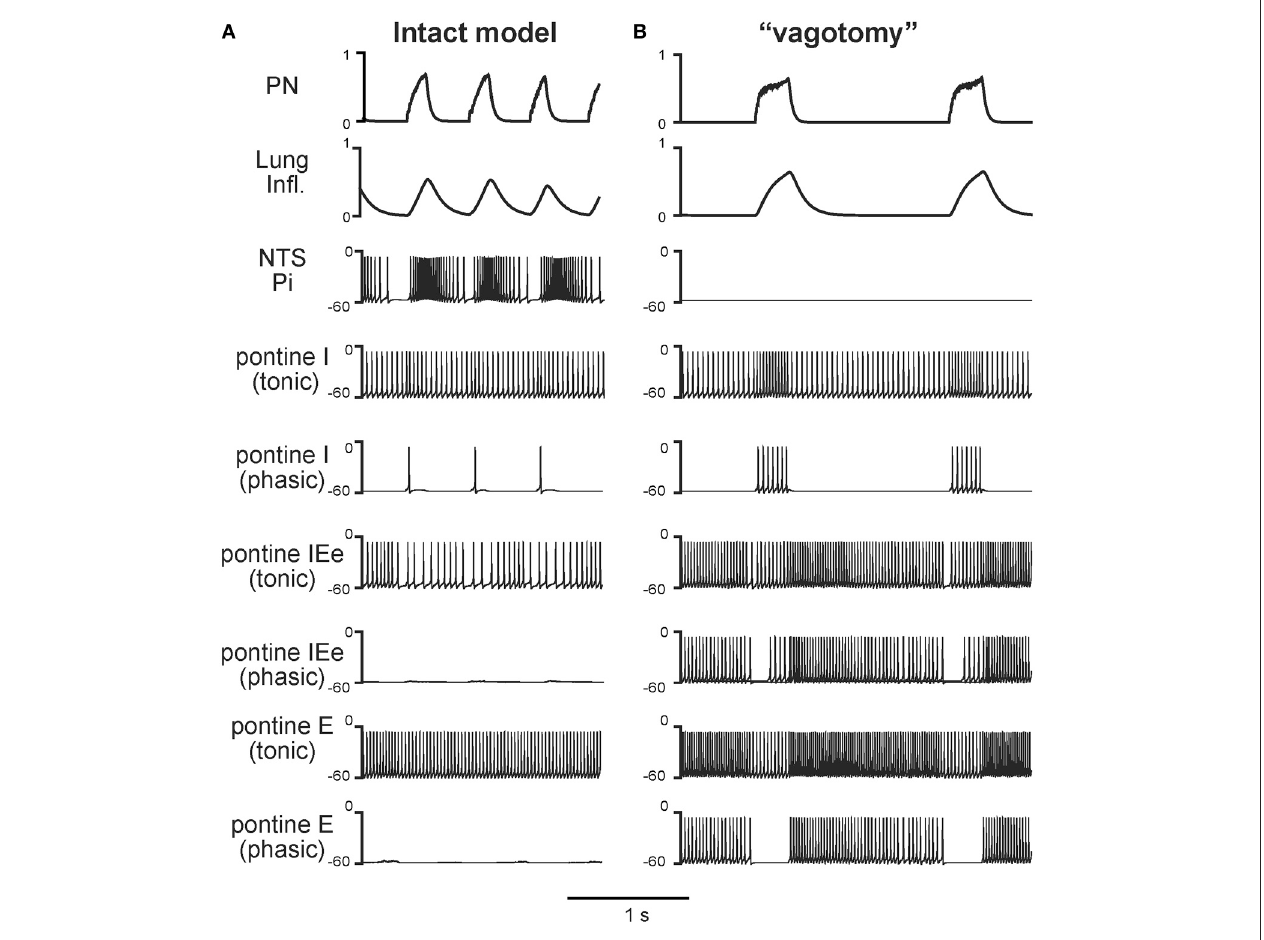
FIGURE 4 | Respiratory modulation in the activity of pontine neurones before (A) and after (B) simulated vagotomy. The changes of phrenic activity (PN) and the lung inflation are shown at the top. Below these graphs,